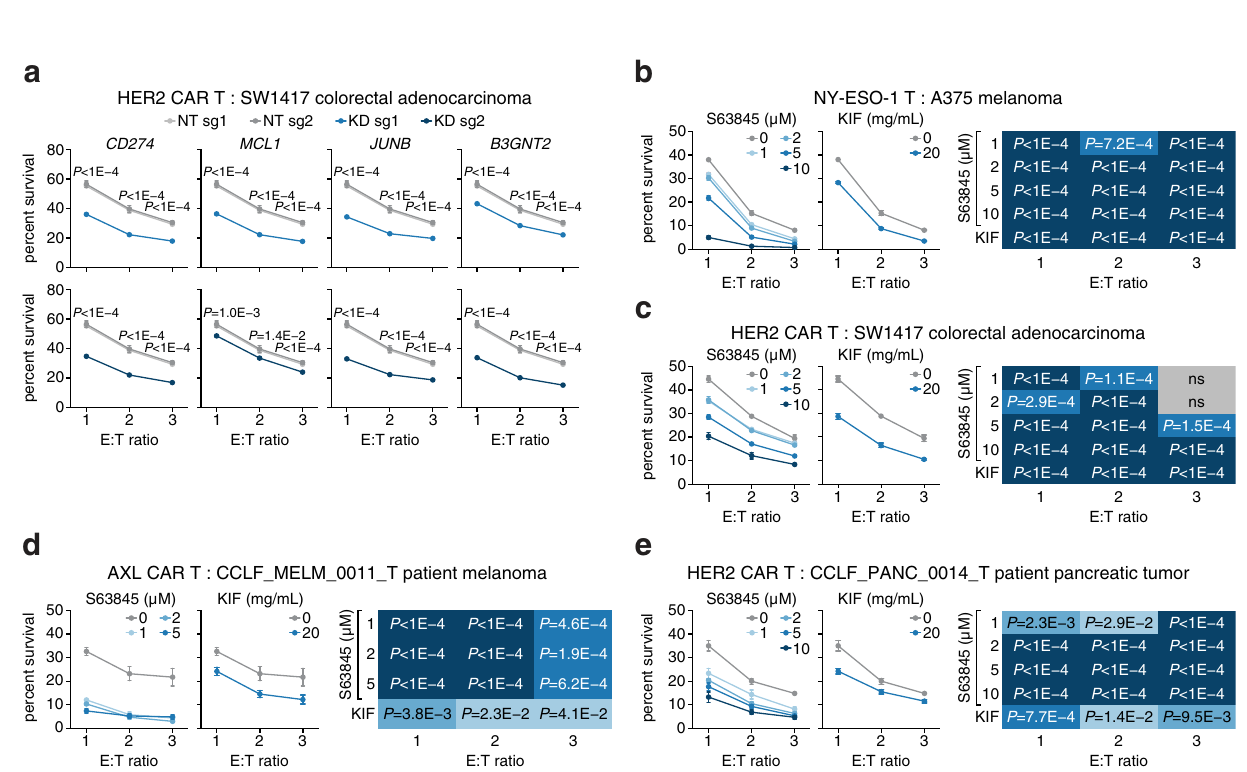
Fig. 4 B3GNT2 disrupts ligand – receptor interactions between tumor and T cells. a Cell survival against T cell cytotoxicity (top) and T cell IFN γ secretion (bottom) in A375 cells overexpressing B3GNT2 or GFP that have been treated with different concentrations of kifunensine. Kifunensine was used to pretreat A375 cells and was present during co-culture with T cells at E:T ratio of 3. Kifunensine-treated cells that were co-cultured with ESO T cells were compared to kifunensine-treated cells cultured in parallel without T cells to determine percent survival. N = 6. Two-tailed t tests were performed. b Tomato lectin IP of A375 cells overexpressing GFP or B3GNT2 followed by western blot for different B3GNT2 target proteins. 2% of the input and no lectin IP controls are shown. Data are representative of two independent experiments. c Western blots of A375 cells overexpressing B3GNT2 or GFP that were treated with kifunensine (KIF) or benzyl-2-acetamido-2-deoxy- α -D-galactopyranoside (BAG) to remove N - or O- glycosylation respectively. Data are representative of two independent experiments. d Histograms (top) and corresponding median fl uorescence intensity (MFI; bottom) showing binding of recombinant T cell proteins to A375 cells measured by fl ow cytometry. A375 cells were overexpressing GFP or B3GNT2 and treated with KIF or BAG. N = 3. Two-tailed t tests were performed. e Schematic showing the tumor cell surface ligands and receptors modi fi ed by B3GNT2 to disrupt interactions with T cells that mediate cytotoxicity. All values are mean ± s.e.m. ns not signi fi cant. Source data are provided in Source Data 4.